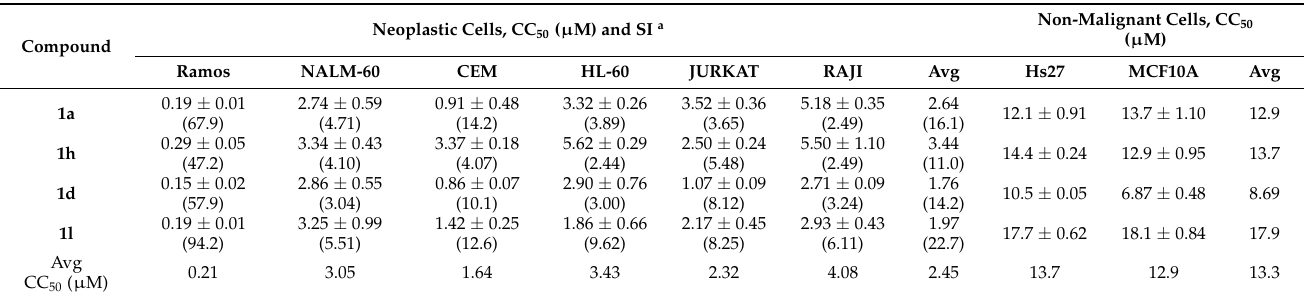
Table 5. Evaluation of 1a , 1d , 1h, and 1l against a number of neoplastic and non-malignant cell